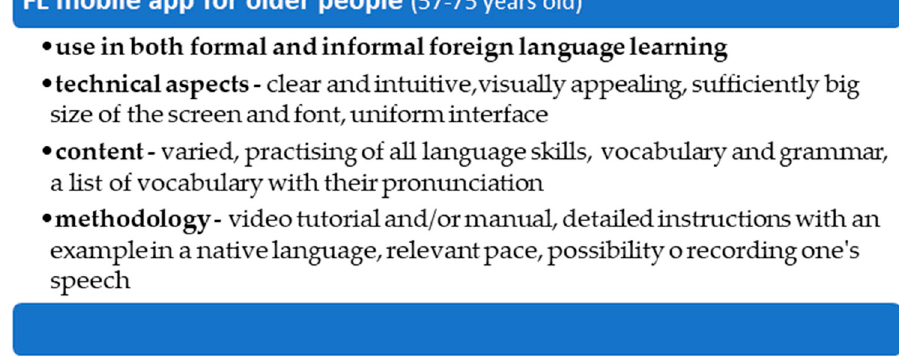
Figure 11. Summary of the key findings.